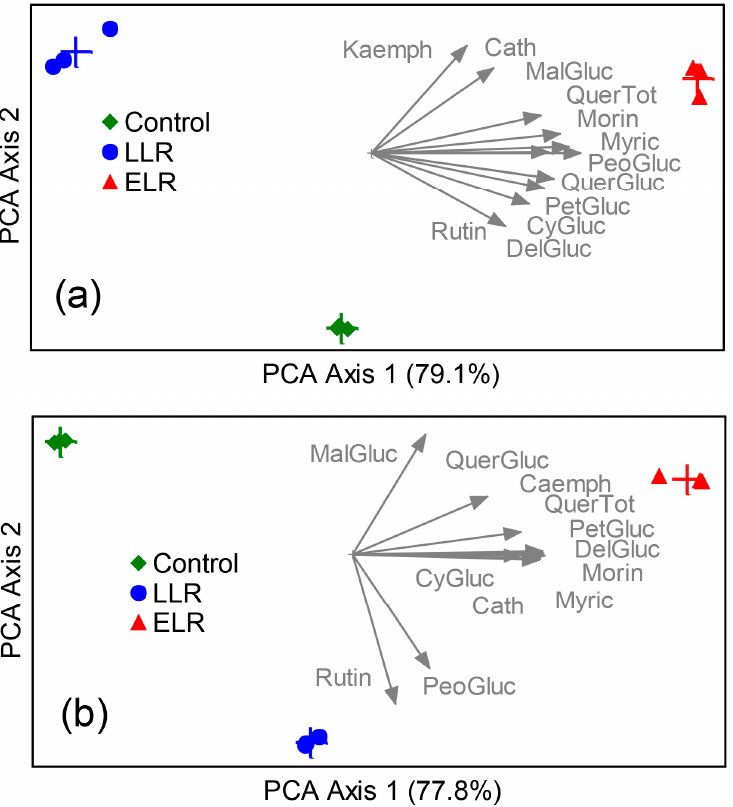
Figure 6. Major gradients (PCA ordination) in the concentrations of 12 chemical compounds determined by HPLC in the berry skin ( a ) and the wine (after 6 months of aging) ( b ) of Cabernet Sauvignon across the three treatments: Control (no leaf removal); LLR (late leaf removal) and ELR (early leaf removal). The values in parenthesis denote the proportion of variance represented by each statistically significant PCA axis. The angles and lengths of the radiating lines indicate the direction and strength of relationships of the variables with the ordination scores. Data matrix: 9 samples collected in one representative year (2012), 12 variables, correlation cross-product matrix, Euclidean distance, no rotation. Samples (3 per leaf removal treatment) are shown, together with group centroids (crosses) which point the average position of a sample within each treatment. Chemical compounds are abbreviated as in Tables 5 and 6. All the variables were correlated with the ordination scores by >35%.